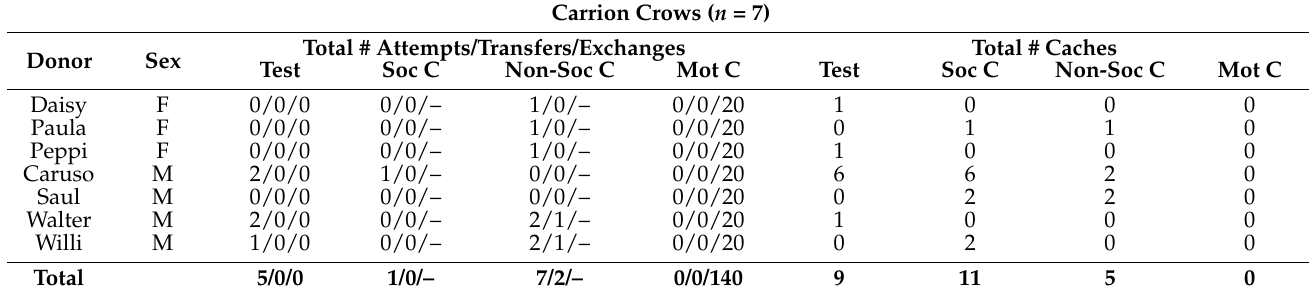
Table 1. Name and sex of the donor, total number of attempted transfers, successful transfers, and exchanges, as well as the total number of caches in the 4 different conditions. Soc C = social control, Non-Soc C = non-social control, Mot C = motivation control. Note that the donor itself performed exchanges in the motivation control. * All of the attempted transfers and transfers listed here occurred at the outer wire mesh of the aviary, opposite to the other compartment and near to where the exchange table was placed in this condition (blue dashed line in Figure